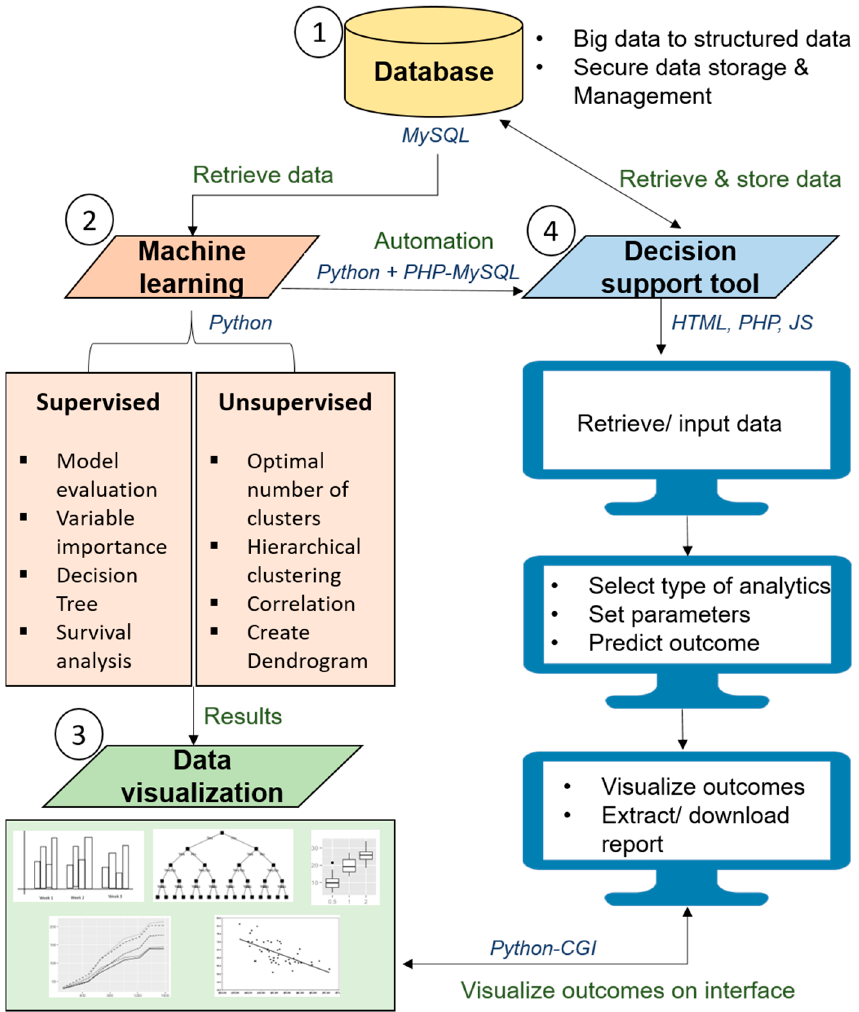
Figure 7. Pipeline to develop automated health research platform with machine